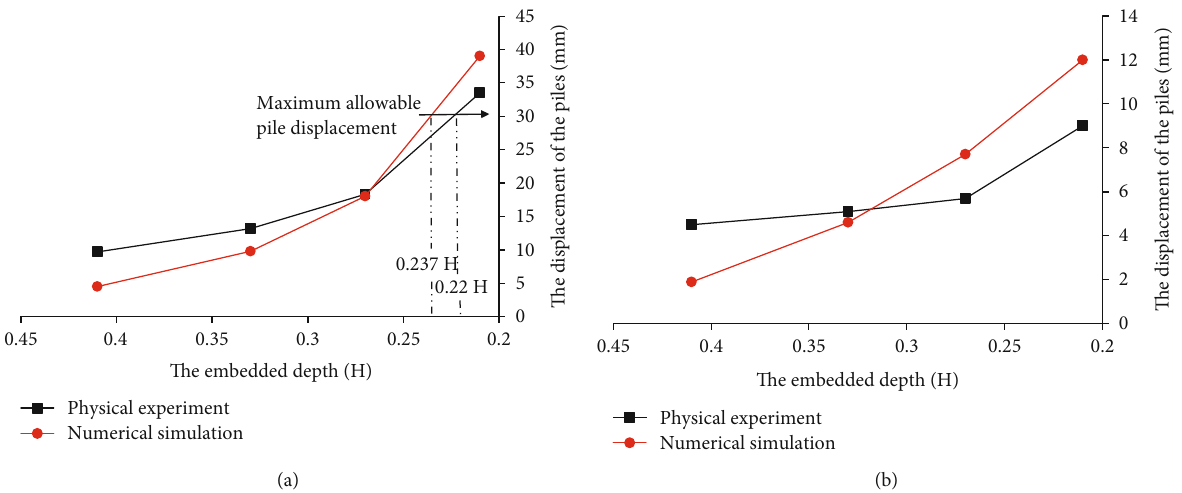
Figure 10: Comparison between the model test and numerical simulations: (a) comparison of the displacement; (b) comparison of the soil